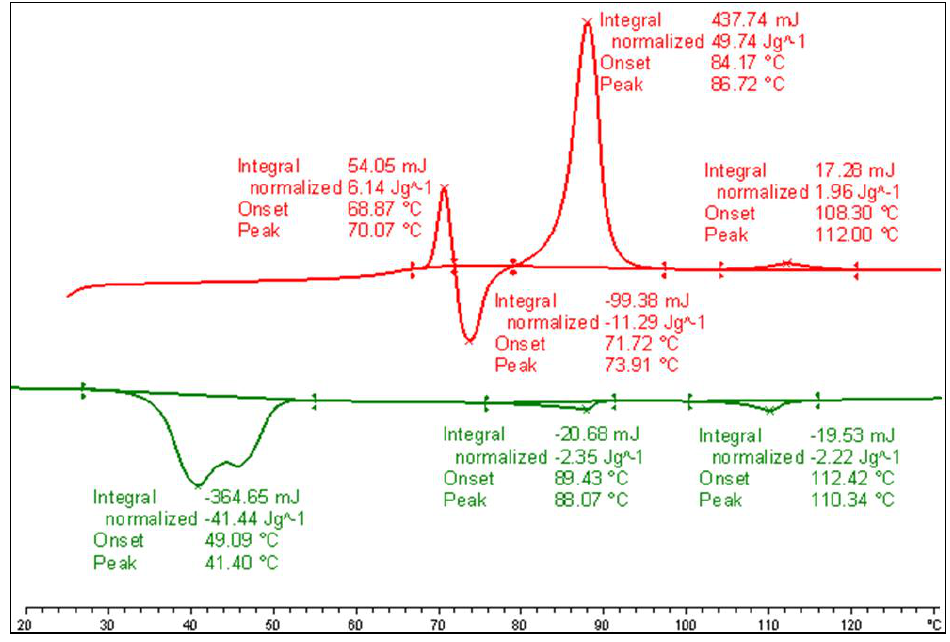
Figure 11. DSC studies (10 K/min) of the binary mixture, MGTP208 (15% (w/w) 2 in 85% CB_C9_CB ); the values are taken from the first heating and cooling scans. Cr 86.7 (49.74) N 112.0 (1.96) Iso (°C); Iso 110.3 (−2.22) N 88.1(−2.35) N Cr (°C); the numbers in brackets are the transition enthalpies in J∙g −1